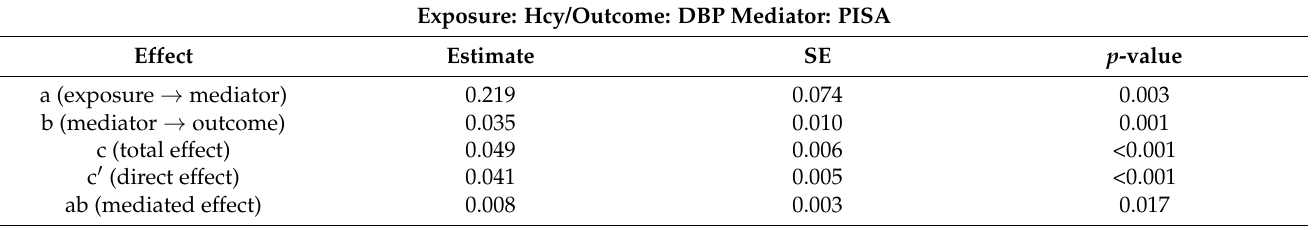
Table 5. Mediation analysis of the effects of PISA and PESA on the association of Hcy levels with DBP ( n = 4021). Exposure: Hcy/Outcome: DBP Mediator: